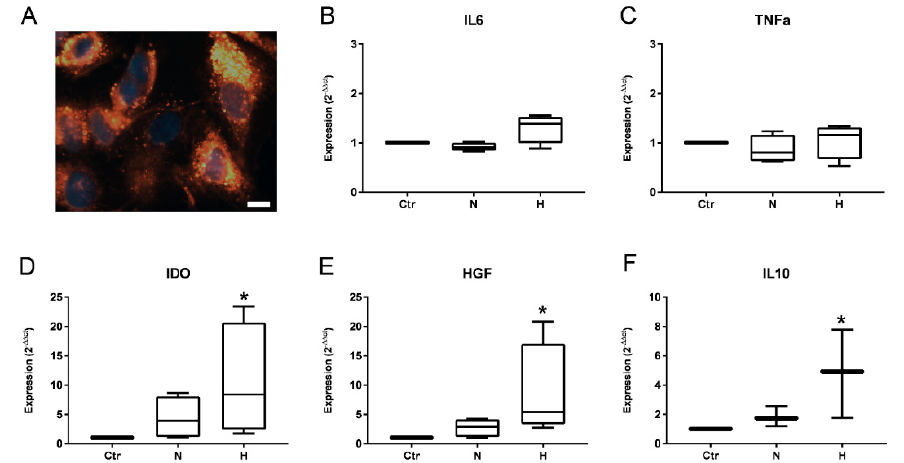
Figure 7. Effect of ASC-EVs on renal epithelial cells in vitro. ( A ) Fluorescence microscopy of PKH26- stained EVs incorporated in renal tubular epithelial cells (blue: staining of cell nuclei with DAPI), bar = 10 μ m. ( B – F ) PCR analysis. TECs were seeded on 6-well plates and incubated for 24 h ( n = 4, four biological replicates from four cell isolations). Thereafter, the cell culture medium was replaced with serum-free M199 without EVs (Ctr), with nEVs (N) or with hEVs (H) (8 μ g EV protein/10 5 cells), and incubated for 48 h. Next RNA was isolated using NucleoZol and used for quantitative PCR. Expression of three anti-inflammatory and two pro-inflammatory targets was calculated by 2 − ∆∆ ct . Analyses show data from three to four independent experiments (Box-Whisker-plots (Median